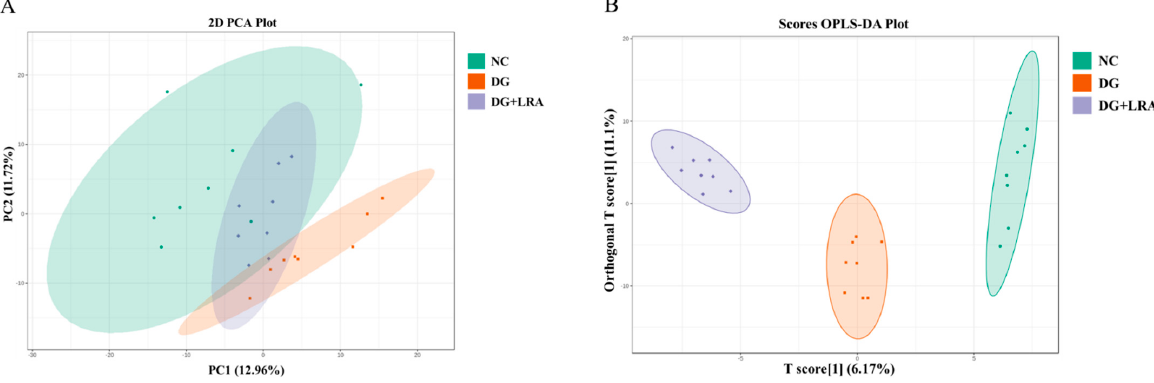
Figure 2. Influence of LRA on the serum metabolism of DG-induced aging rats ( n = 8). ( A ) 2D PCA score plot. ( B ) Scores OPLS-DA plot. ( C ) Volcano plot. ( D ) Venn diagram showing the relationship between different metabolites in each group. Red dots, VIP ≥ 1; Green dots: VIP < 1. 3.5. Screening for the Differential Metabolites